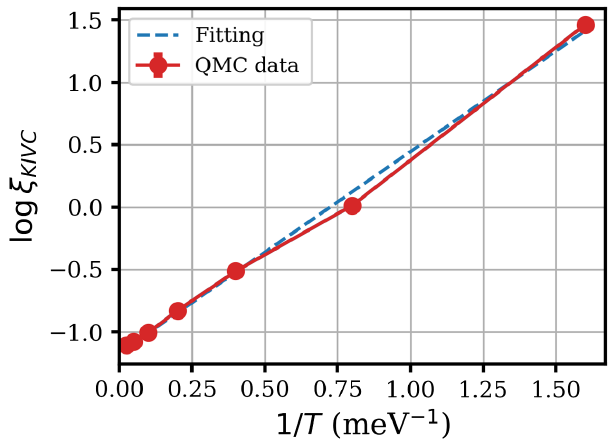
FIG. 12. Here, we plot log ξ against the inverse of temper- KIVC ature, 1 =T . Using the relation in Eq. (G11), we extract the stiffness to be ρ ∼ 1 . 03